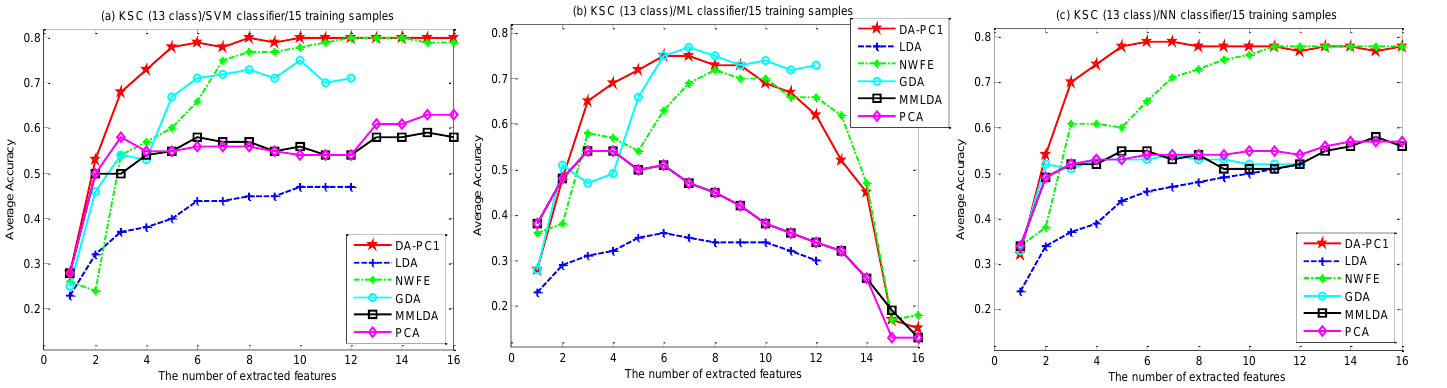
Figure 2. The average classification accuracies versus the number of extracted features for KSC dataset using 15 training